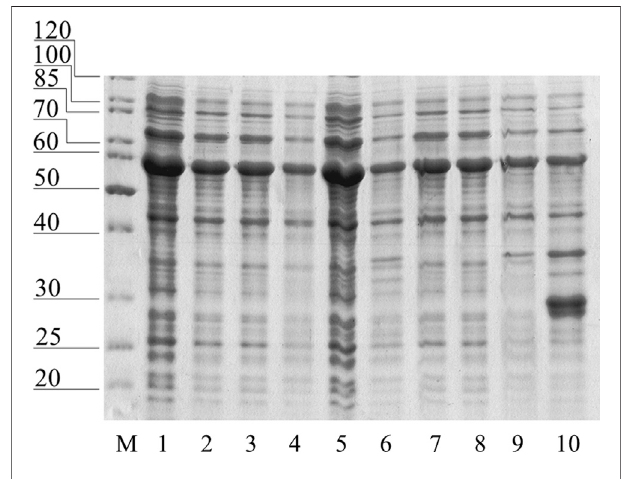
FIGURE6| Solublefraction of E.coli after expression ofmutant formsof Chit19: 1 — Chit19, 2 — Chit19(C191A), 3 — Chit19(C231S), 4 — Chit19 (C286T), 5 — Chit19(C191A, C231S, C286T), 6 — Chit19 Δ ChBD, 7 — Chit19 Δ ChBD (C191A), 8 — Chit19 Δ ChBD (C231S),